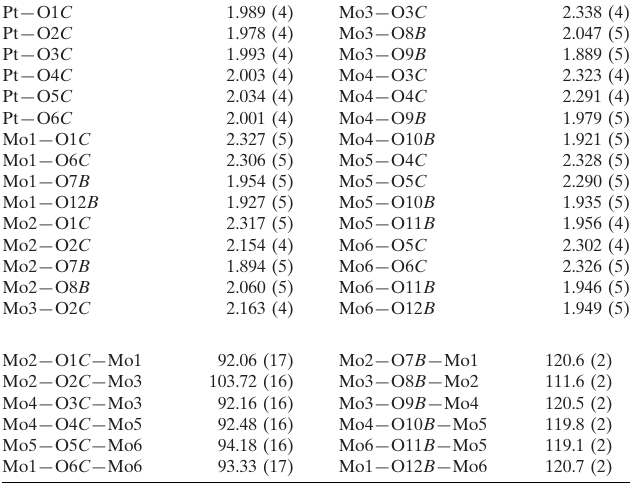
Selected geometric parameters (A˚ , (cid:4) ).